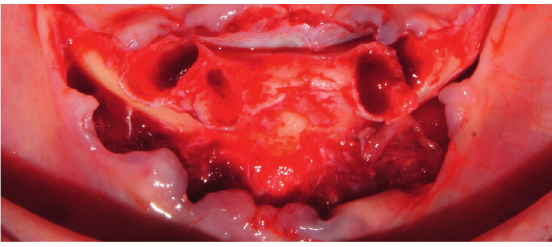
Figure 3: Fresh postextraction sockets.